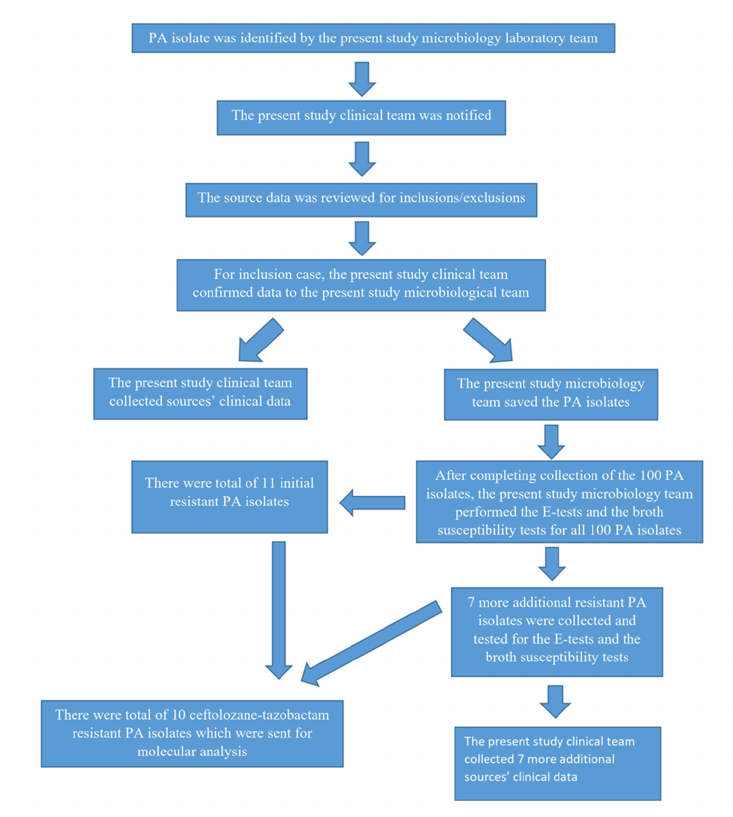
Figure 1. Study Figure 1. Study flowsheet.